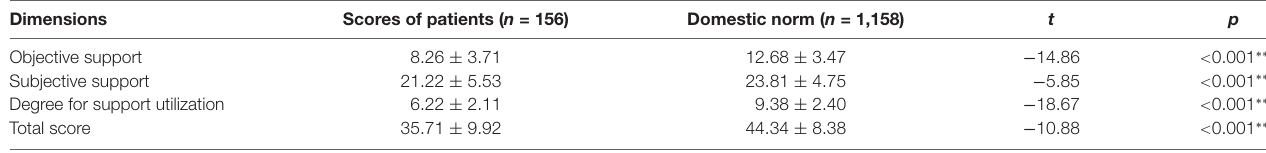
TABLE 5 | Comparison of social support in patients with complicated hepatolithiasis and domestic norms ( n = 156, ¯ x ± s).